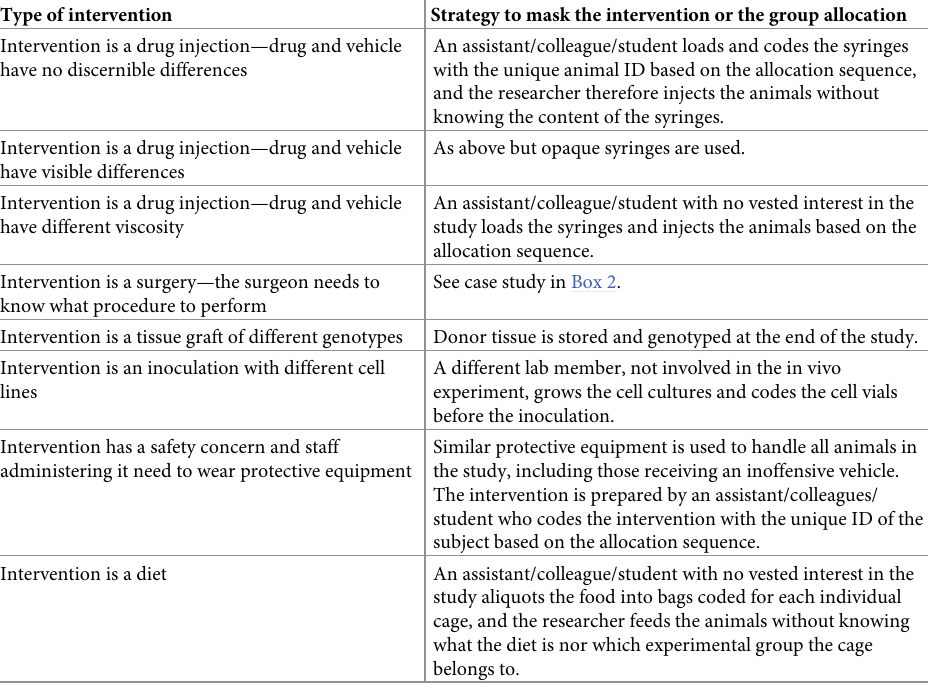
Table 4. Example of strategies to implement masking during the allocation. Type of